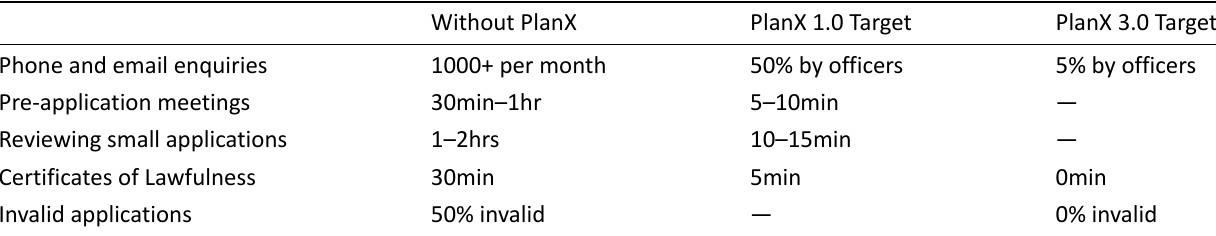
Table 1. Projected workload efficiency for PlanX.